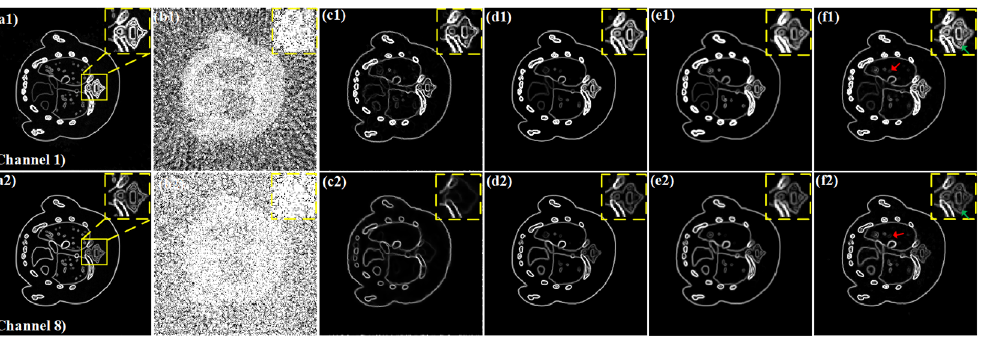
Figure 5. The gradient images from 80 views. The first row is the first energy channel and the second row is the eighth energy channel. From left to right, the columns are Ground Truth, FBP, TV, TVLR, TDL, and our algorithm. The display windows are [0, 0.08] cm − 1 and [0, 0.02] cm − 1 . Table 1. Comparison of indicators in different angles using different methods.